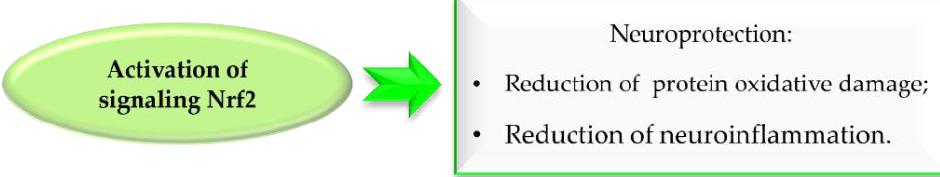
Figure 33. Effect of Nrf2 signalling activation in Parkinson ’ s disease.